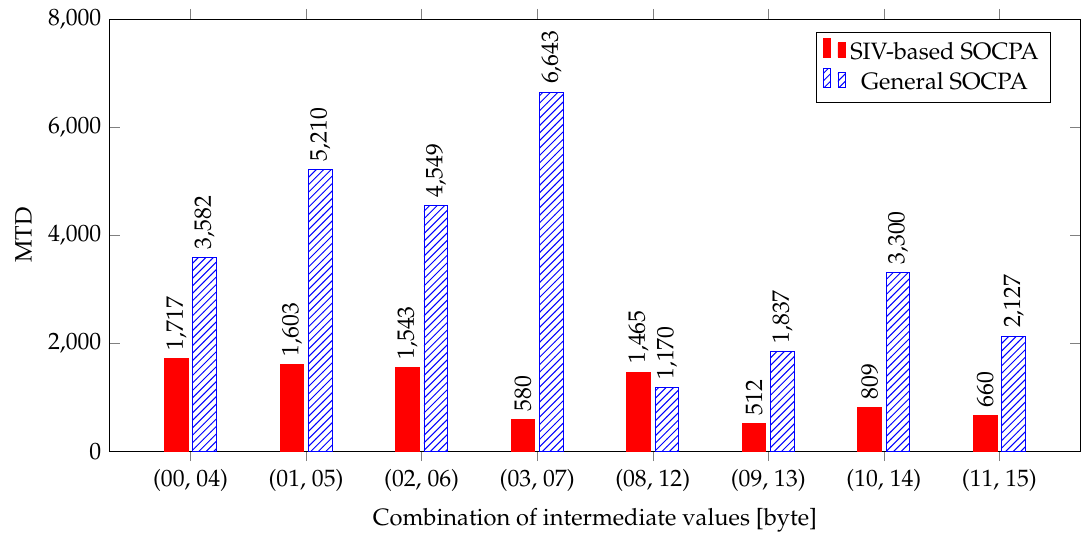
Figure 8. Minimum trace to disclosure for MixColumns